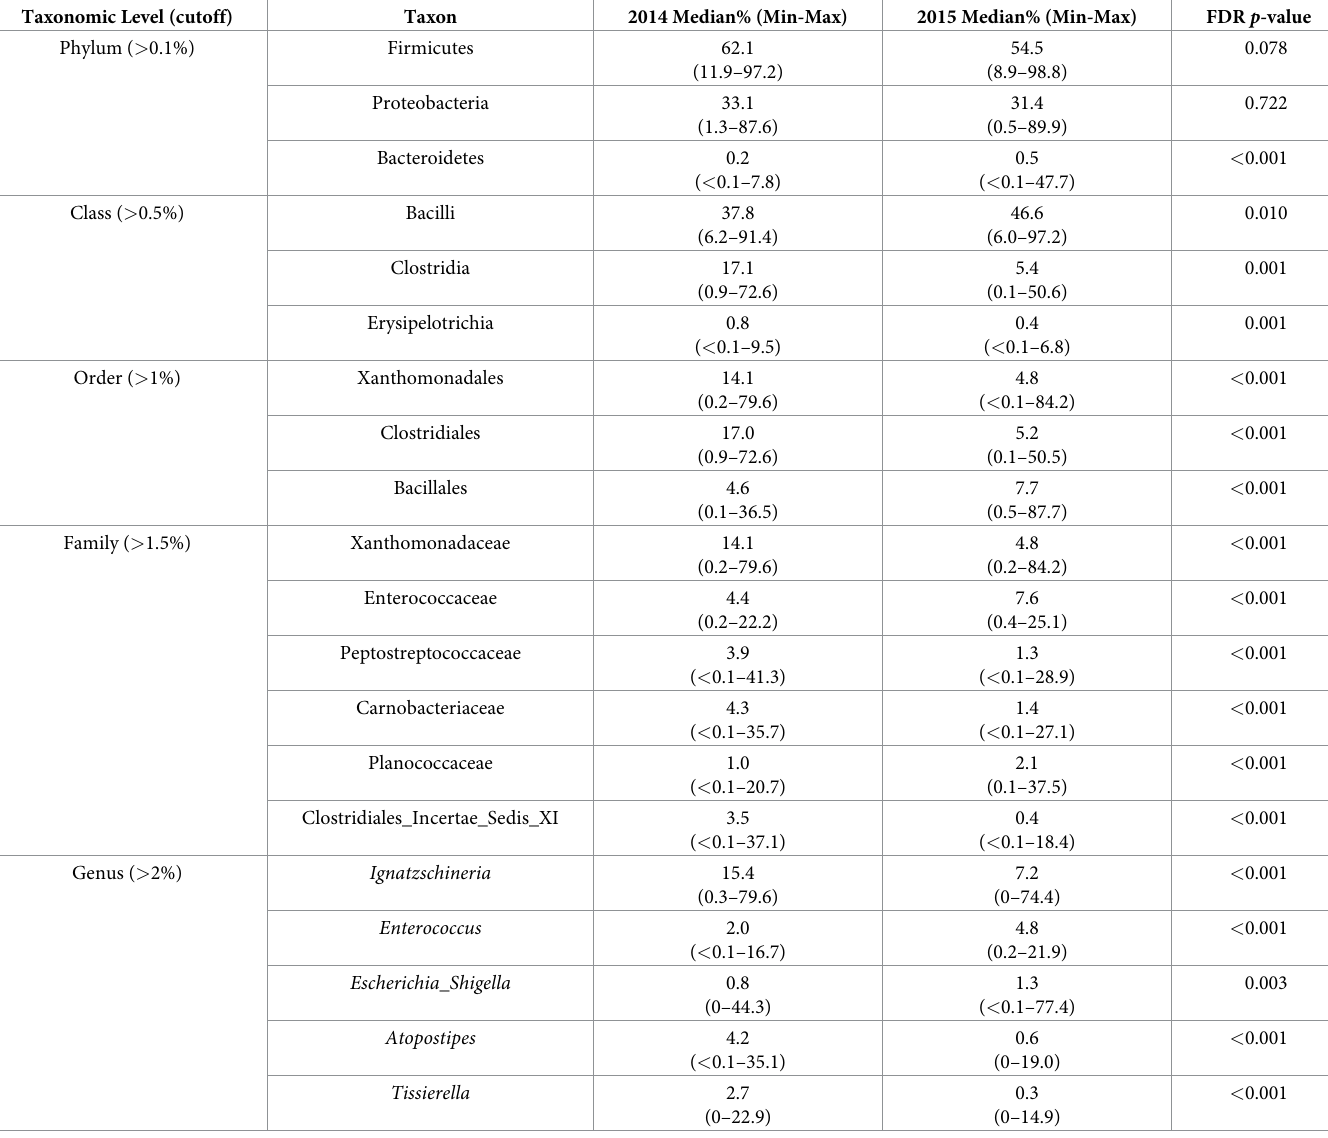
Table 5. Relative abundance and false discovery rate p -values by year, for which at least 1 significant difference was identified between years from the fecal micro- biota of mink, at each taxonomic level (n = 332). Samples were obtained from 43 and 46 farms in 2014 and 2015,